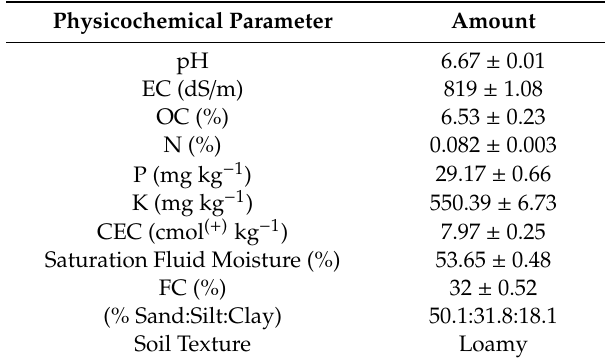
Table 2. Physicochemical characteristics (mean values ± SE) of the forest nursery soil before the start of the pot experiment.